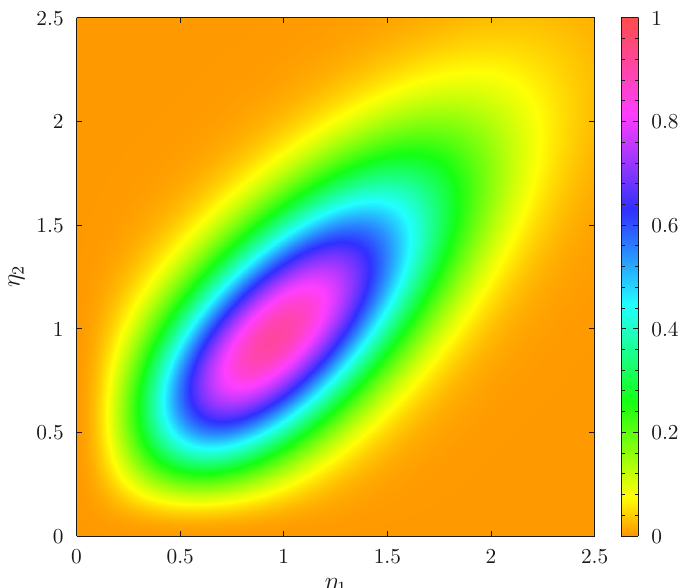
Figure 3. The rescaled passage probability λ 2 P 2 ( x 1 , y ; x 2 , − y ) as function of the rescaled coordi- nates η 1 = x 1 /λ , η 2 = x 2 /λ for 2 y/R = 0 . 1